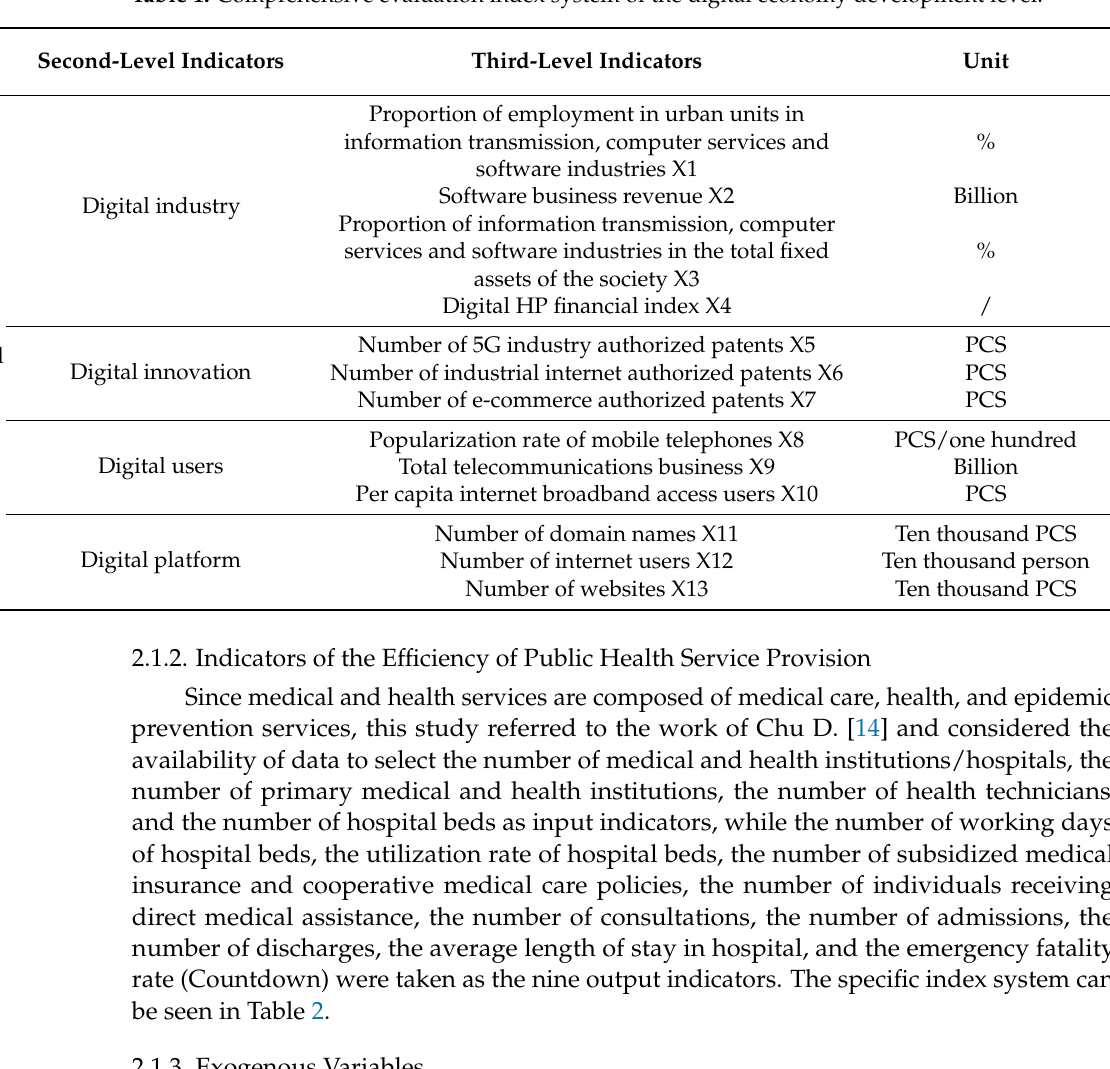
Table 1. Comprehensive evaluation index system of the digital economy development